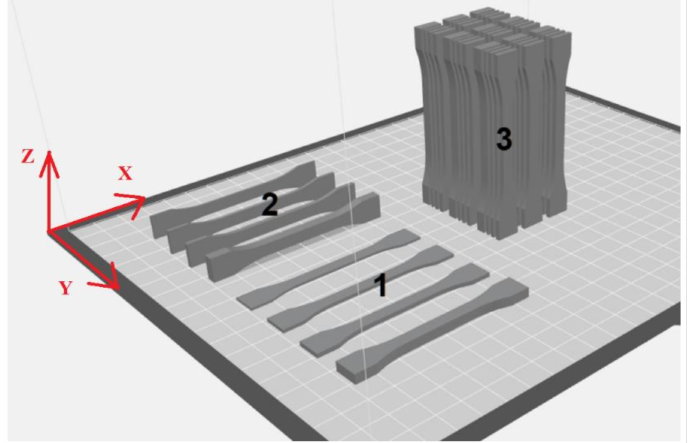
Figure 2. Arrangement of models on the build plate of the MakerBot printing machine; orientation along: 1—the x axis, 2—the y axis, and 3—the z axis.